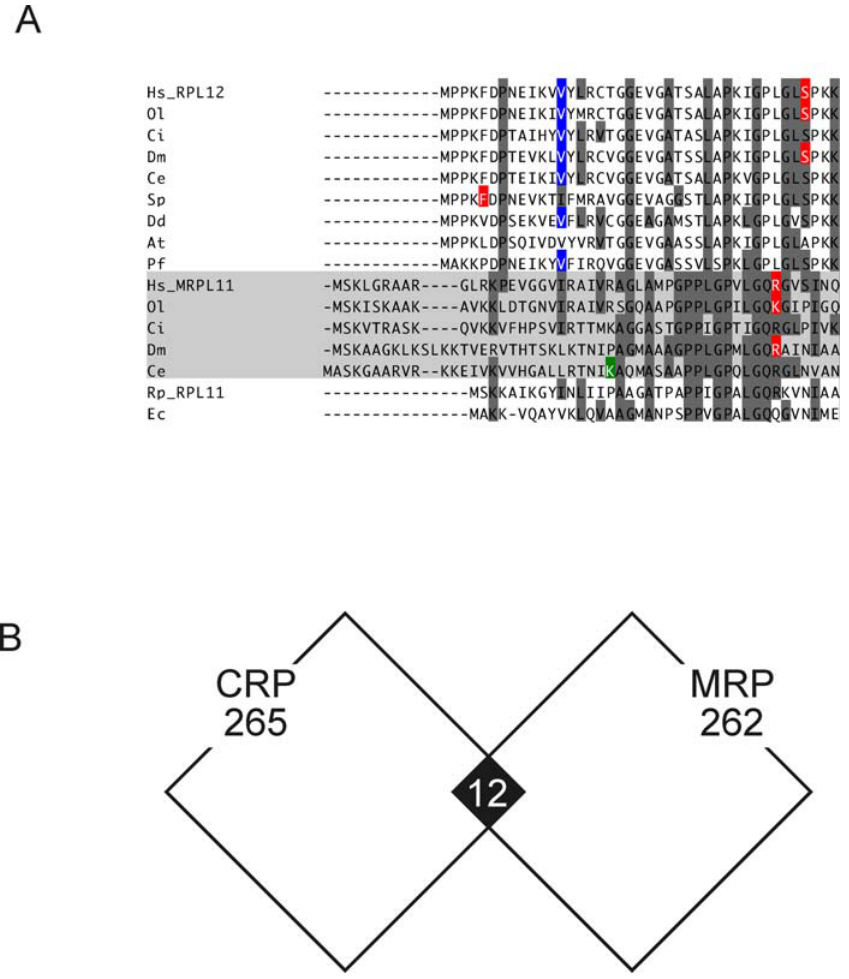
Figure 1. Comparison of Intron Positions Shared by CRP and MRP Genes (A) A part of the sequence alignment of nine RPL12 genes (top), five MRPL11 genes (light grey shading), and two prokaryotic RPL11 genes (bottom). Conserved amino acids are highlighted by a dark grey background. Phase 0, 1, and 2 introns are highlighted by red, blue, and green backgrounds, respectively. (B) A Venn diagram of overlap showing that 12 intron positions are shared by CRP and MRP genes. CRP and MRP genes have 265 and 262 intron positions, respectively. At, A. thaliana; Ce, Ca. elegans; Ci, Ci. intestinalis; Dd, Di. discoideum; Dm, Dr. melanogaster; Ec, E. coli; Hs, H. sapiens; Ol, O. laptides; Pf, P. falciparum; Rp, R. prowazekii; Sp, S. pombe